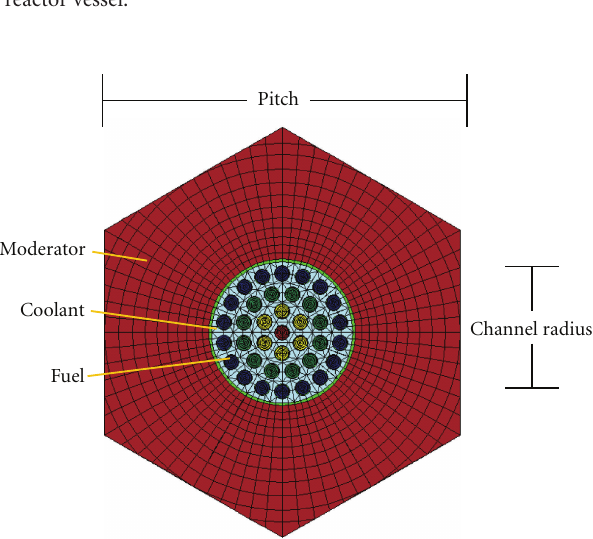
Figure 1: Atucha-II reactor vessel.